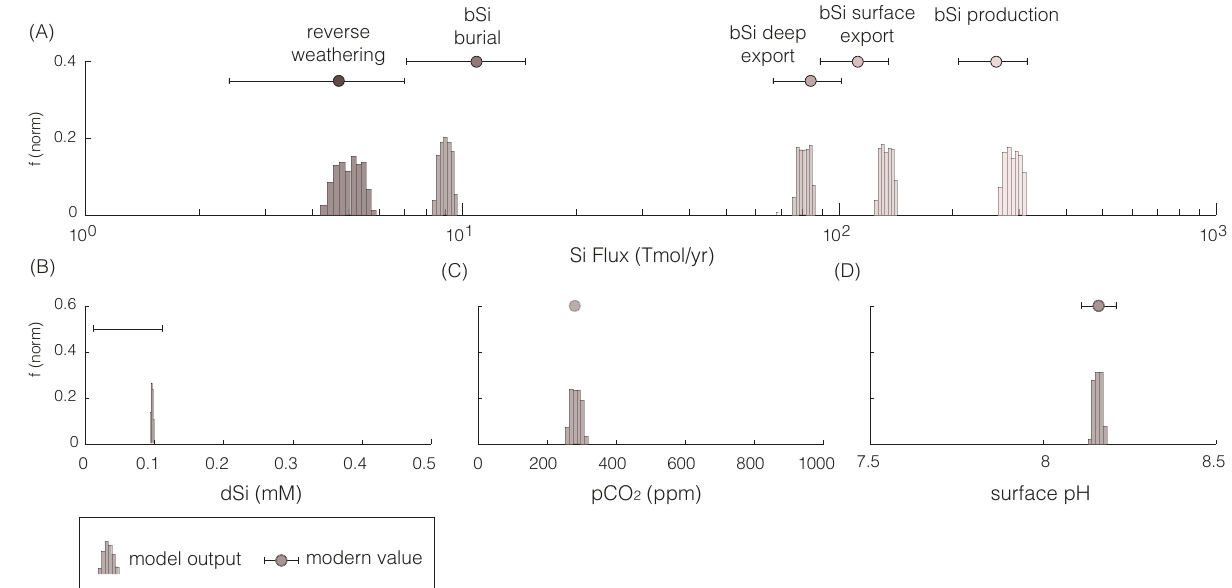
Fig. 3 Carbon – silica cycle model calibration. The modern-day values of ( A ) marine silica fl uxes including biogenic silica (bSi) production, surface to deep export, deep to sediment export, sediment burial, and reverse weathering, B surface-dissolved silica levels, C preindustrial atmospheric CO 2 levels and ( D ) surface-seawater pH are reproduced by our model. Parameters utilized include n si = 0.2, n carb = 0.1, p CO c axis indicates frequency (normalized) of the Monte Carlo